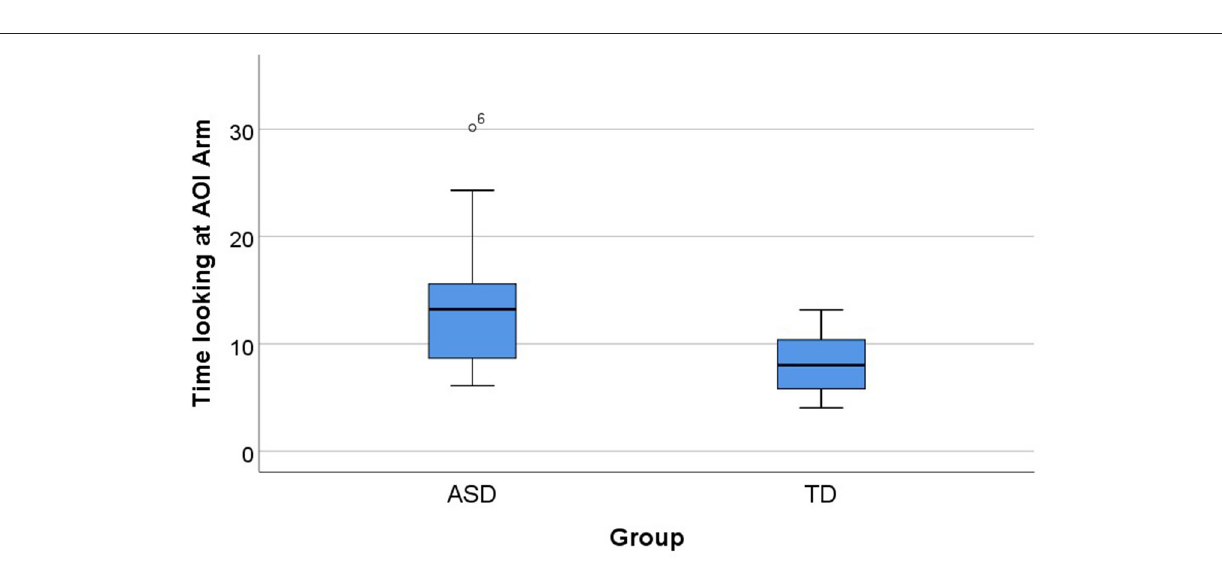
FIGURE 8 | Group differences in the AOI arm ( U = 64.00, p = 0.009, d = 1.012). Total time for ASD and TD groups in the AOI arm in the social salient cue condition. Boxplots: central mark—median; edges of box − 25th and 75th percentiles; whiskers—most extreme data points (minimum and maximum). AOI, area of interest; ASD, autism spectrum disorder group; TD, typical neurodevelopment